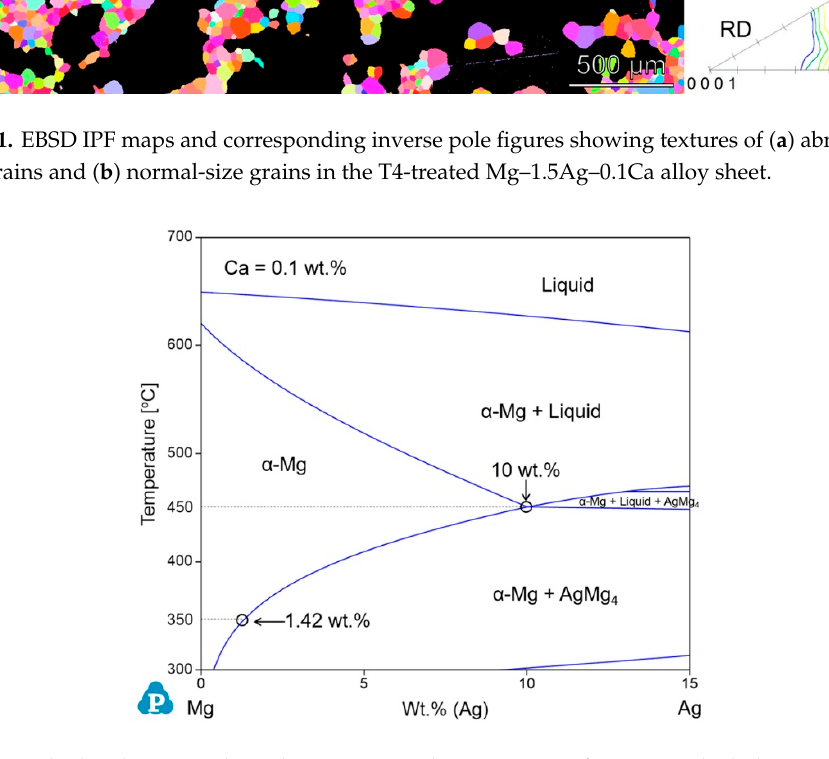
Figure 12. Calculated Mg-Ag phase diagram using the PANDAT software, in which the Ca content is fixed as 0.1 wt.%.